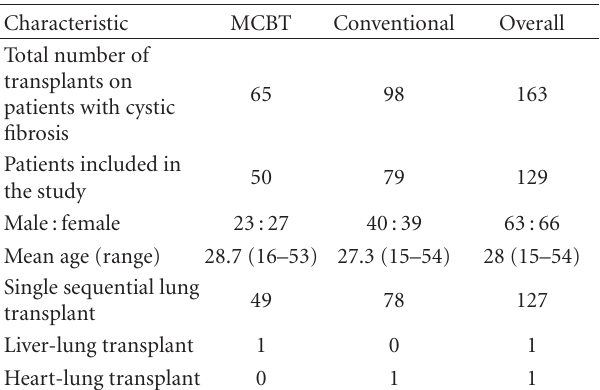
Table 1: Patient characteristics.